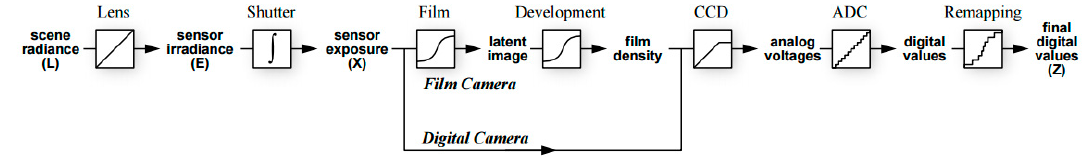
Figure 8. Image acquisition pipeline.